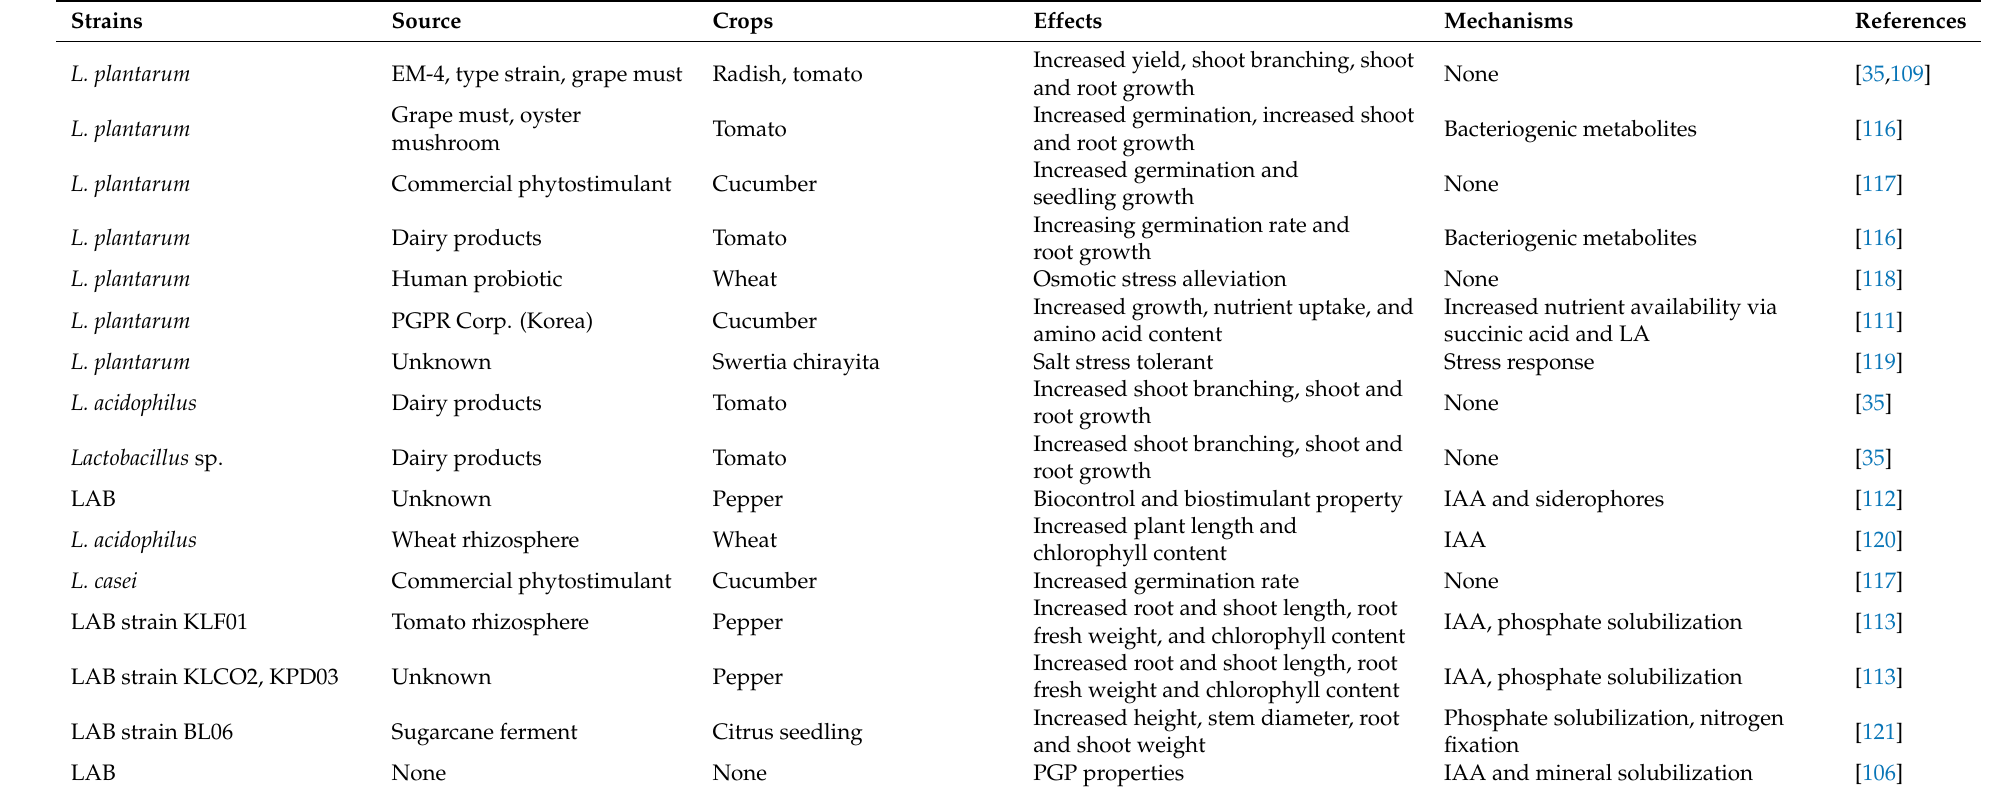
Table 3. LAB biostimulants and biofertilizer properties on sustainable crop production (PGPR—plant-growth-promoting rhizobacteria; IAA—indole acetic acid; LA—lactic